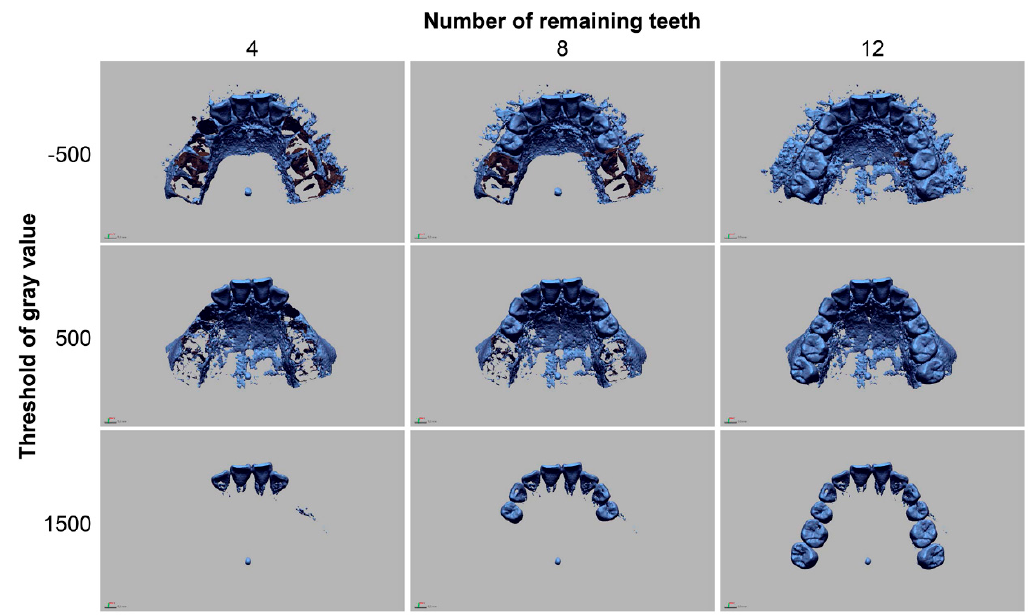
Figure 2. 3D reconstruction images of cone-beam computed tomography in the different conditions of the threshold of gray value of segmentation and remaining teeth.